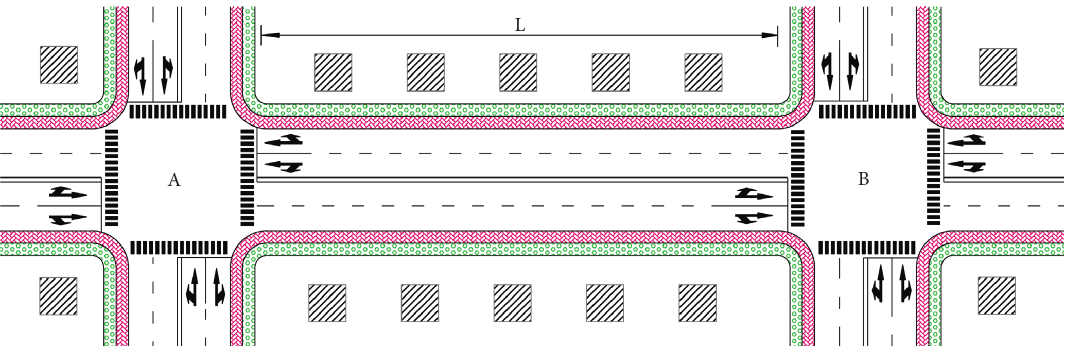
Figure 5: The road section being